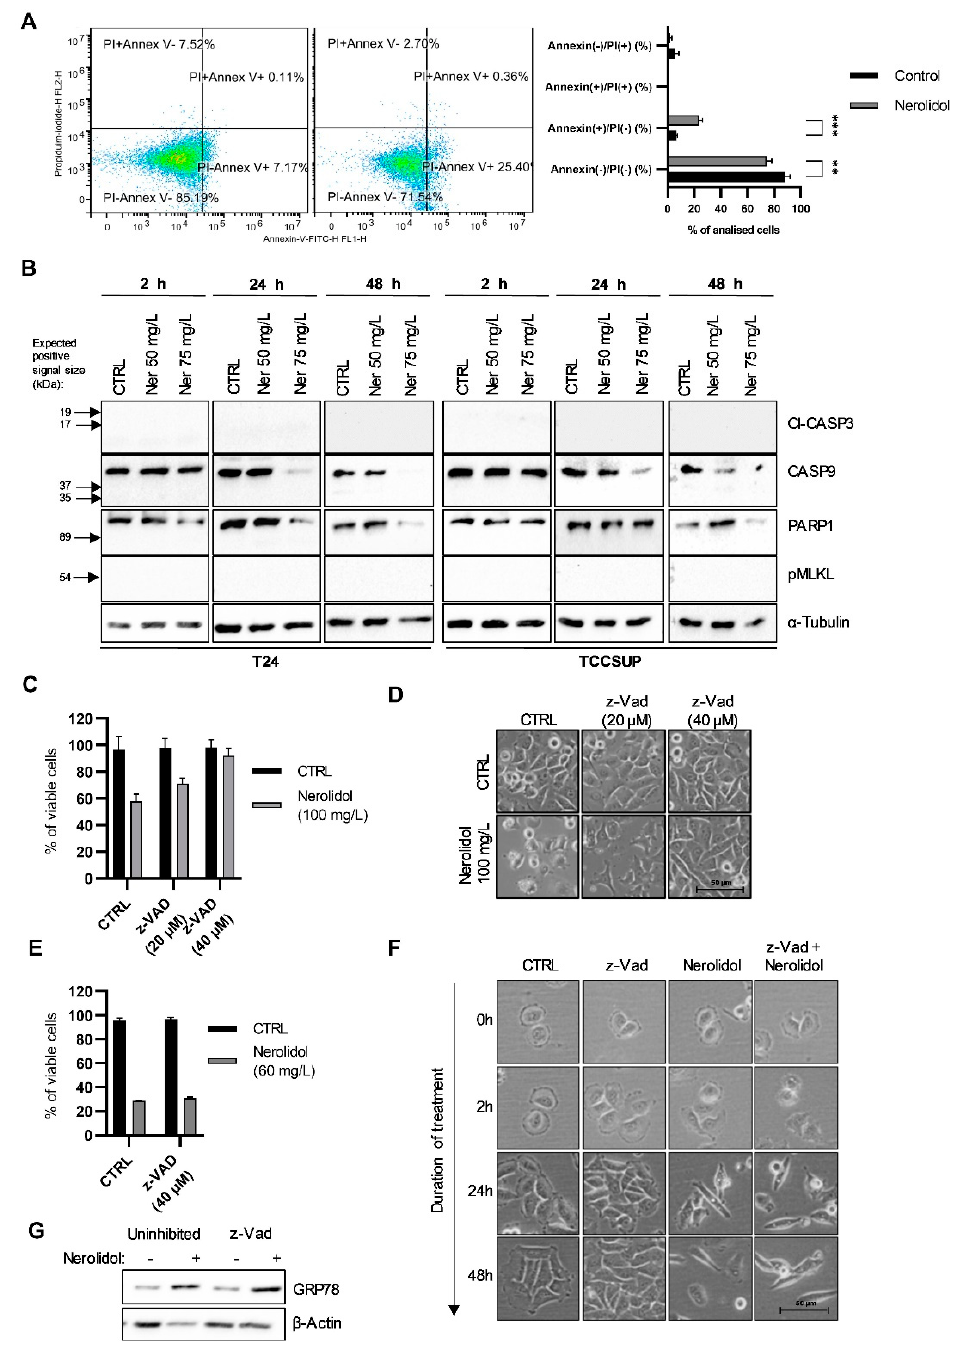
Figure 7. The two pathways of cell death differ by their involvement of caspases. ( A ) Flow cytometry results of annexin V/PI staining on TCCSUP cells untreated (left) or treated (right) with 50 mg/L of nerolidol for 48 h. The chart represents the quantification of two independent experiments. ( B ) Im- munostaining of apoptotic and necroptotic factors with cl-CASP3, CASP9, PARP1, and pMLKL on T24 (left) and TCCSUP (right) cells after treatment with 50 and 75 mg/L of nerolidol for 2, 24 and 48 h. ( C ) Cell viability of T24 cells pre-treated with z-Vad (20 and 40 μ M) for 1 h and then treated with 100 mg/L of nerolidol for 2 h determined by cell counting and trypan blue staining. Cell counts were normalized to control cells. ( D ) Cell microscopy images of T24 cells pre-treated with z-Vad (20 and 40 μ M) for 1 h and then treated with 100 mg/L of nerolidol. ( E ) Cell viability of T24 cells pre-treated with z-Vad (40 μ M) for 1 h and then treated with 60 mg/L of nerolidol for 48 h determined by cell counting and trypan blue staining. Cell counts were normalized to control cells. ( F ) Cell microscopy images of T24 cells pre-treated with z-Vad (40 μ M) for 1 h and then treated with 60 mg/L of nerolidol taken at multiple time points following nerolidol administration. ( G ) T24 cells were treated with z- Vad (40 μ M) for 1 h before 60 mg/L nerolidol was administered for 2 h. Immunostaining of GRP78